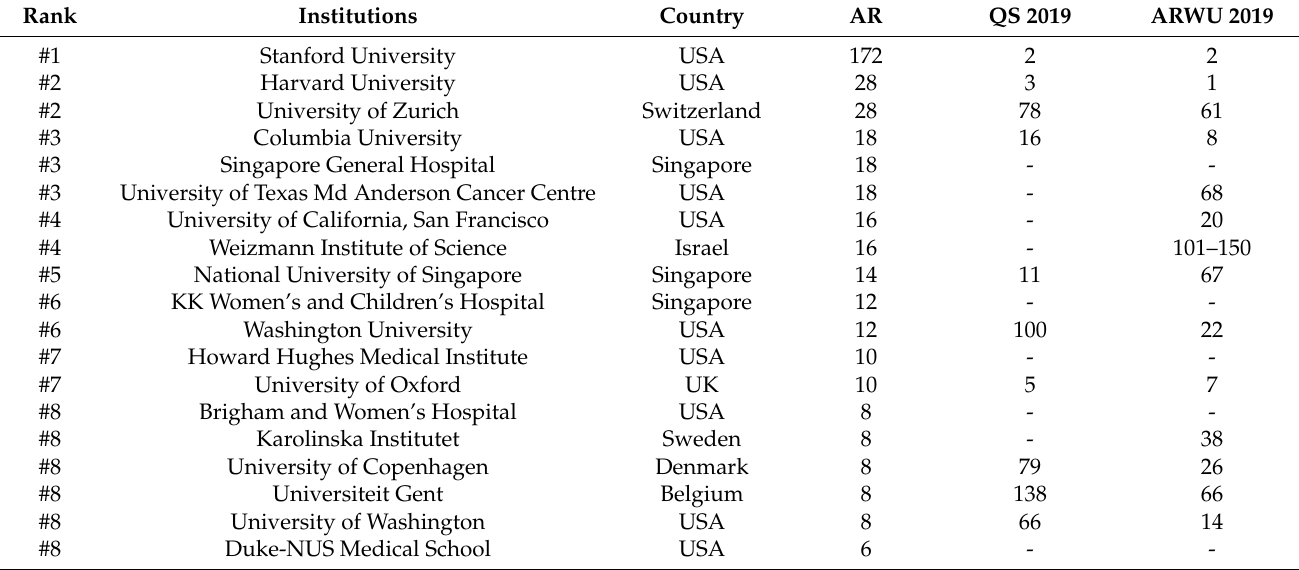
Table 4. Top number of affiliations registered (institutions) in mass cytometry highly cited papers (HCPs). Rank